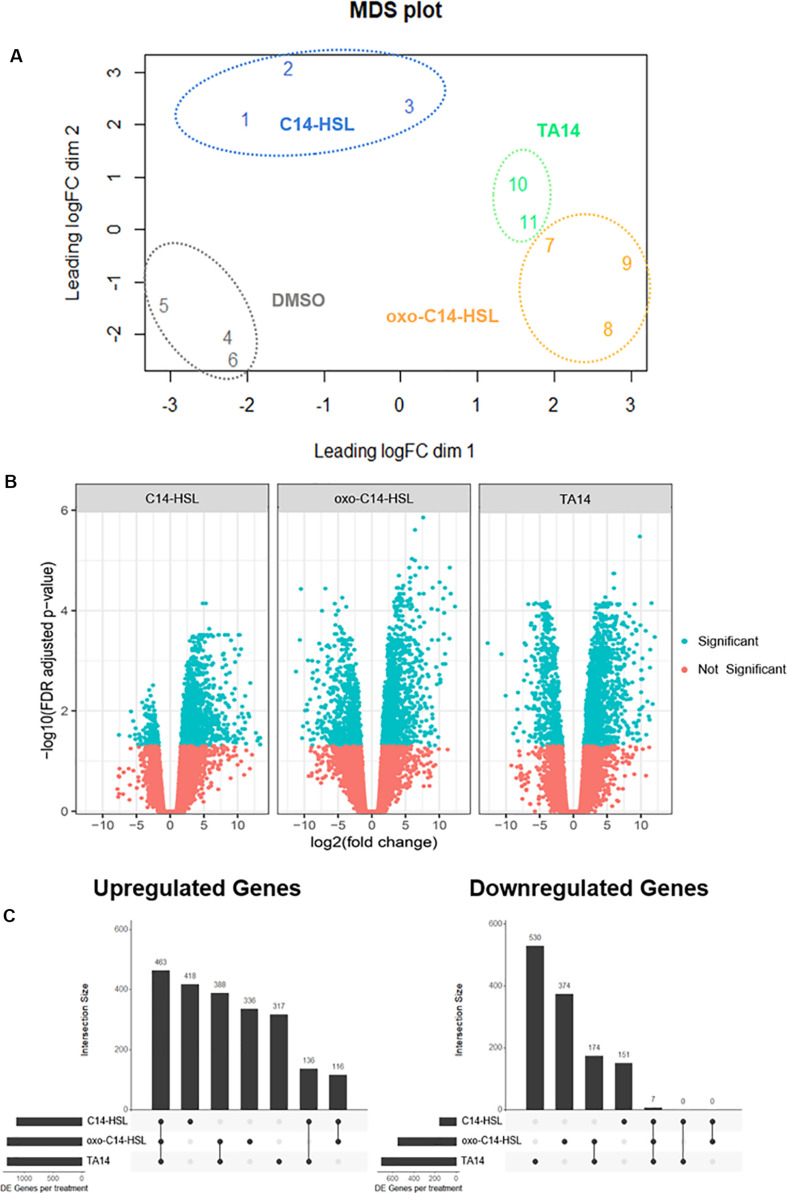
 MDS-, Volcano-, and UpSet-plots of transcriptome data. (A) MDS plot of RNA-seq data. Distances between samples can be interpreted as the typical log2 fold change between them, for the top 500 most discriminative genes. (B) Volcano plots of RNA-seq data. Log2 fold changes versus the log10 FDR adjusted p-values for all three treatments when compared to the control. Significantly regulated genes on a 5% FDR level are highlighted in blue. (C) UpSet-plots of significantly up- and down-regulated genes in C14-HSL, oxo-C14-HSL, and TA14 treatment (|log2 fold change| > 1, FDR ≤ 0.05). The barplot in the top-panel in each plot indicates the number of genes per intersection as depicted in the panel below. Left panel indicates the total number of DE genes per treatment.